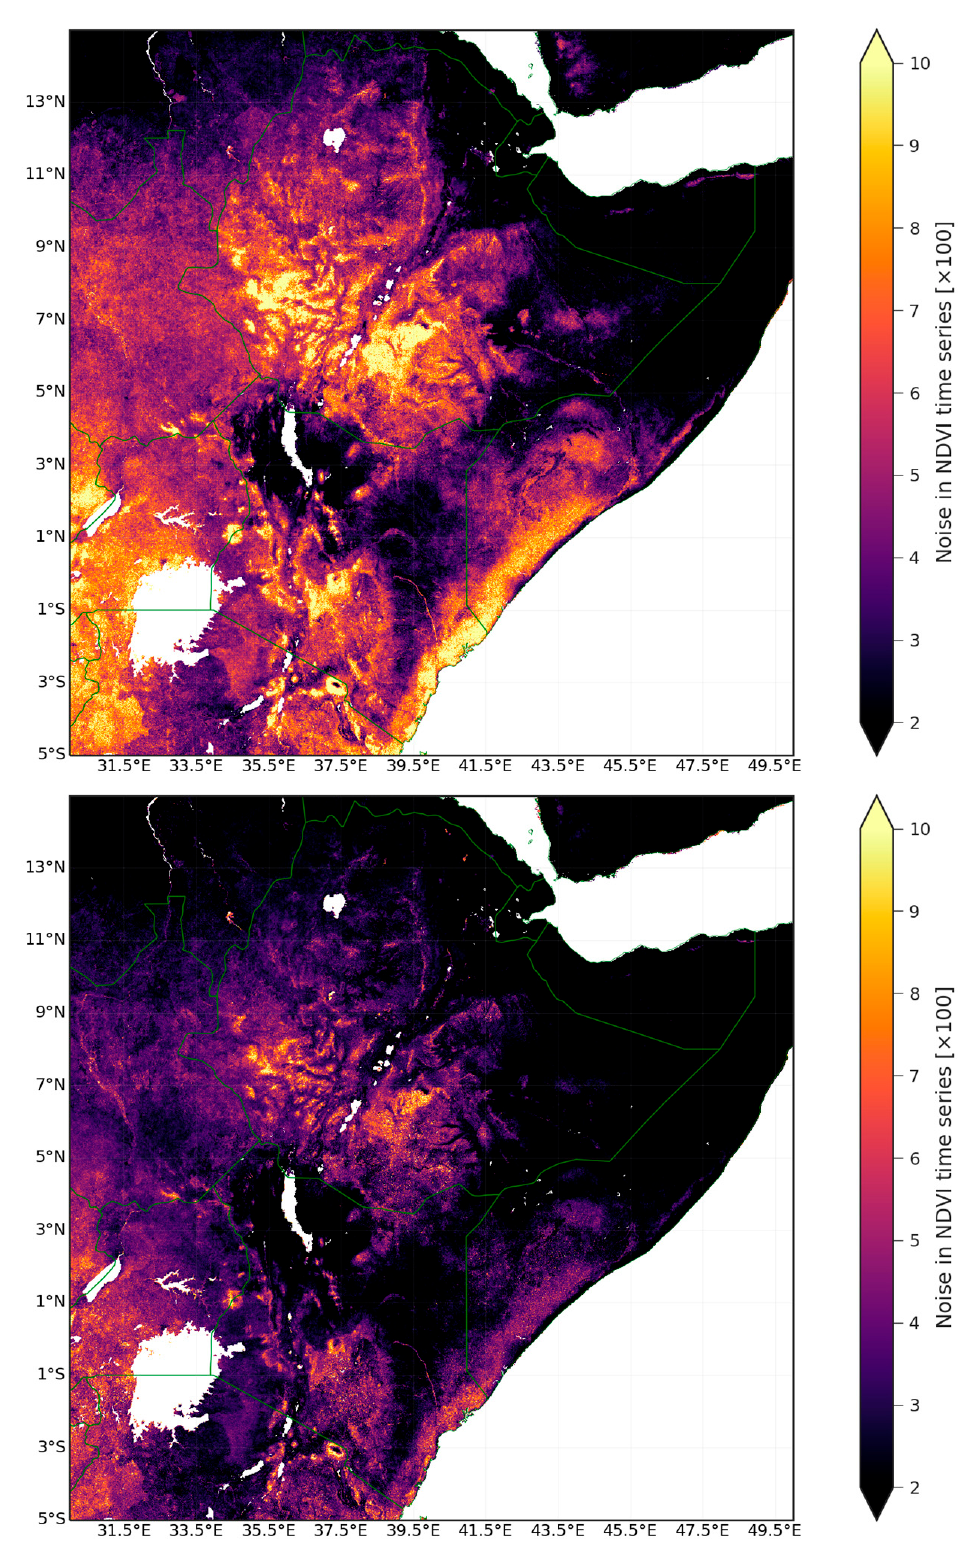
Figure 7. Statistical noise in MVC NDVI ( top-panel ) and BRDF-adjusted NDVI ( bottom-panel ) Time-Series for a region of Eastern Africa encompassing the so-called horn of Africa. Levels of scaled ( × 100) noise estimated from Equation (13) are color coded as shown in the colorbar. It should be noticed that pixels with a scaled noise value higher than 10 are simply shown as light yellow. Country borders are shown as green